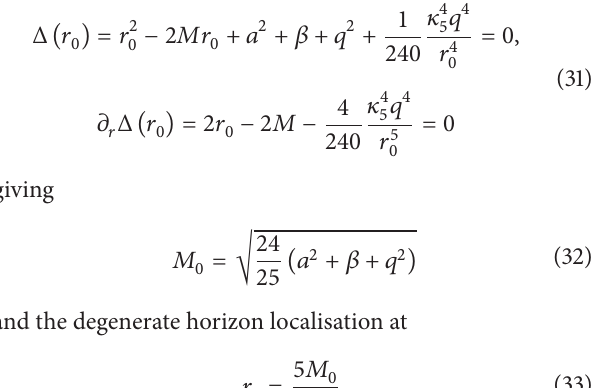
Figure 1: Characteristic behaviour of Δ(𝑟) as a function of 𝑟 for different values of the mass parameter 𝑀 using 𝑞 = 25 , 𝛽 = 25 , and 𝑎 = 50 . The intersections with the 𝑟 -axis give the position of inner and outer horizons. For masses 𝑀 > 𝑀 0 , there are two horizons, while the particular case 𝑀 = 𝑀 0 describes a black hole with one degeneratehorizon.For 𝑀 < 𝑀 0 ,thebehaviourshowsnoblackhole